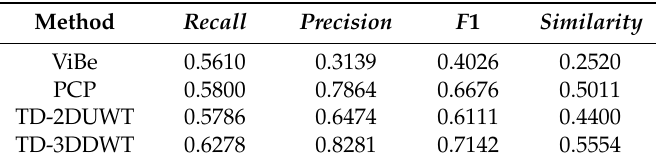
Table 3. Comparison of metrics for the ninth frame of BR96 (Frame 1558).